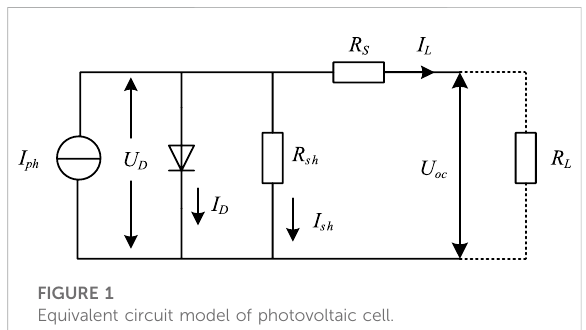
FIGURE 1 Equivalent circuit model of photovoltaic cell.